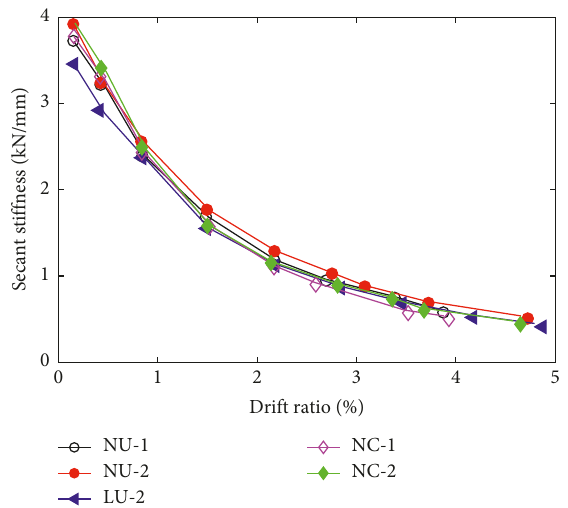
Figure 11: Stiffness degradation